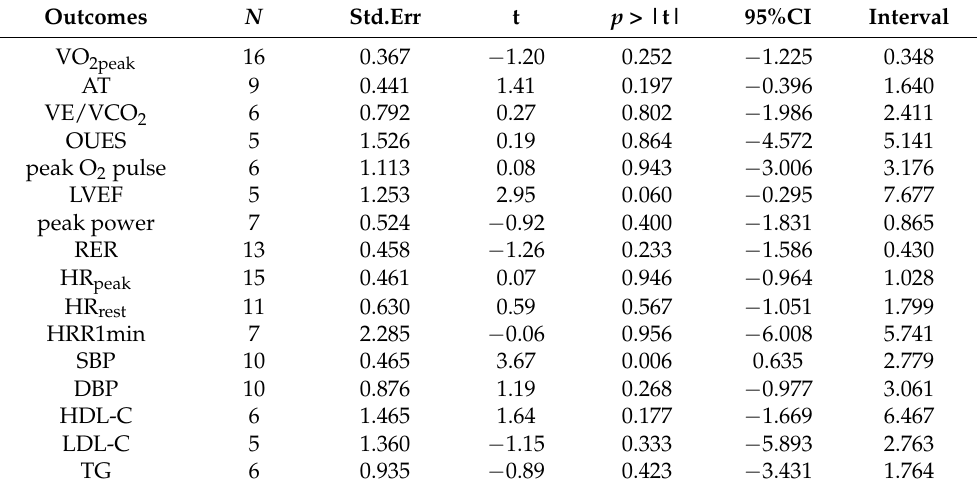
Table 2. Egger’s test of the included studies.